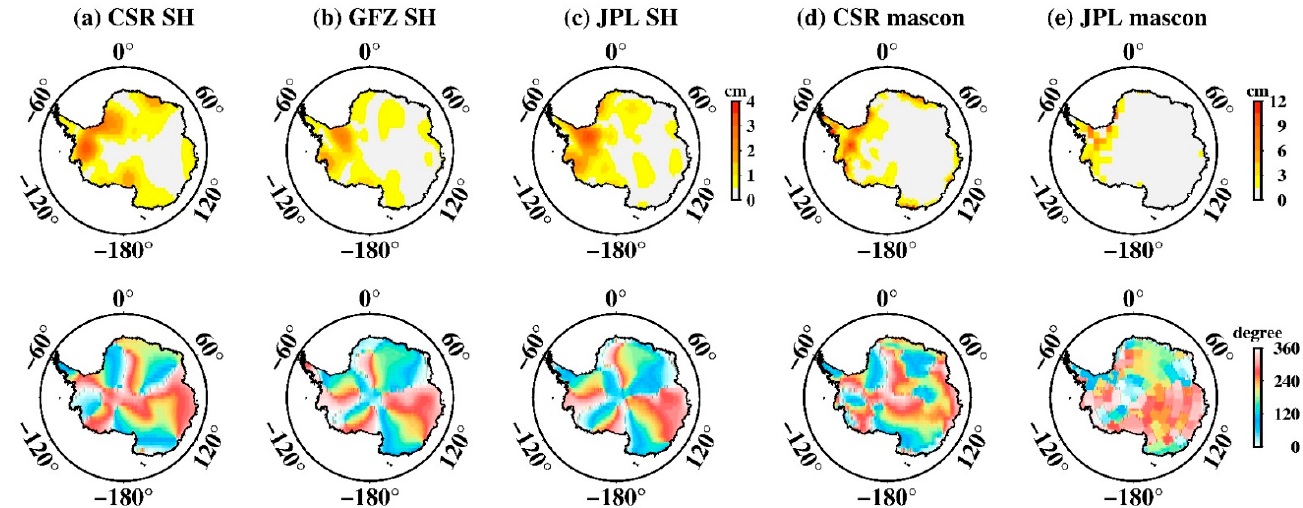
Figure 3. Spatial amplitude and the corresponding phase maps of S 2 tide aliasing over Antarctica. ( a – e ) Estimated from CSR SH data, GFZ SH data, JPL SH data, CSR mascon data, and JPL mascon data, respectively. The upper row is the spatial amplitude and the bottom row is their corresponding phase.